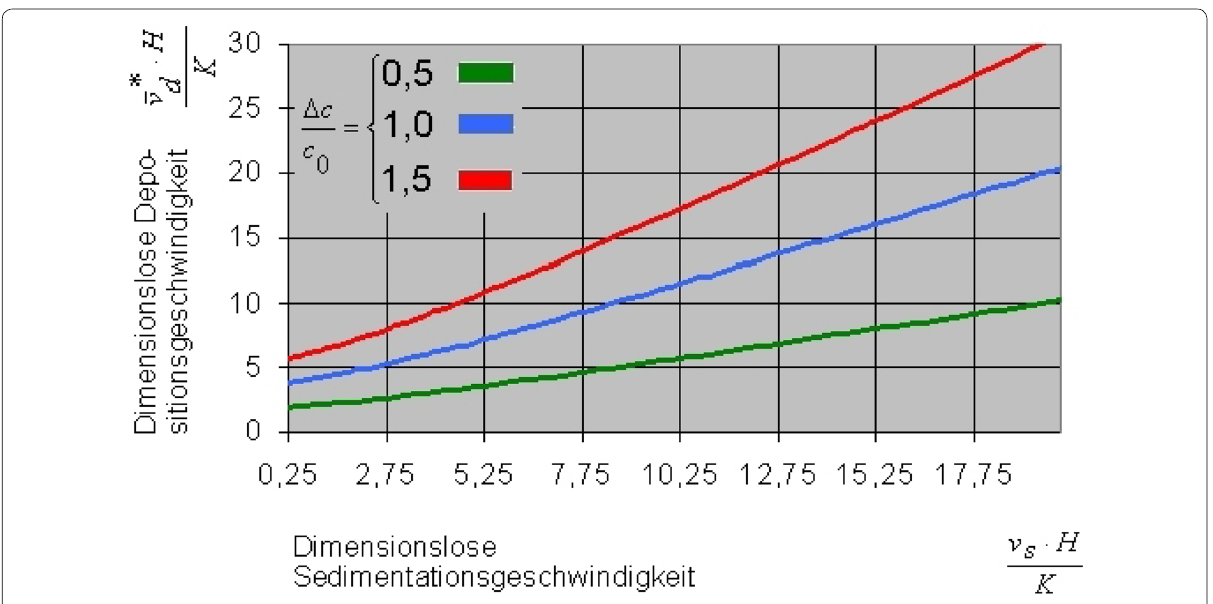
Fig. 3 Approximate calculation of deposition